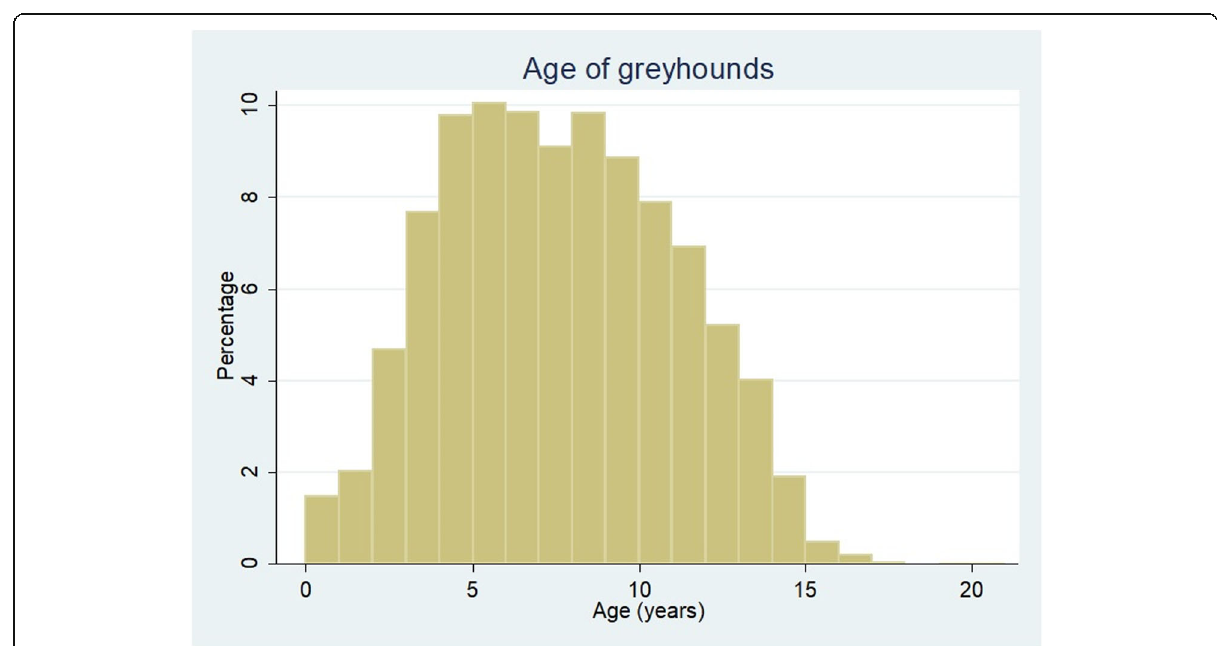
Fig. 1 Ages (years) of greyhounds under veterinary care in the UK during 2016 at practices participating in the VetCompass Programme. ( n =